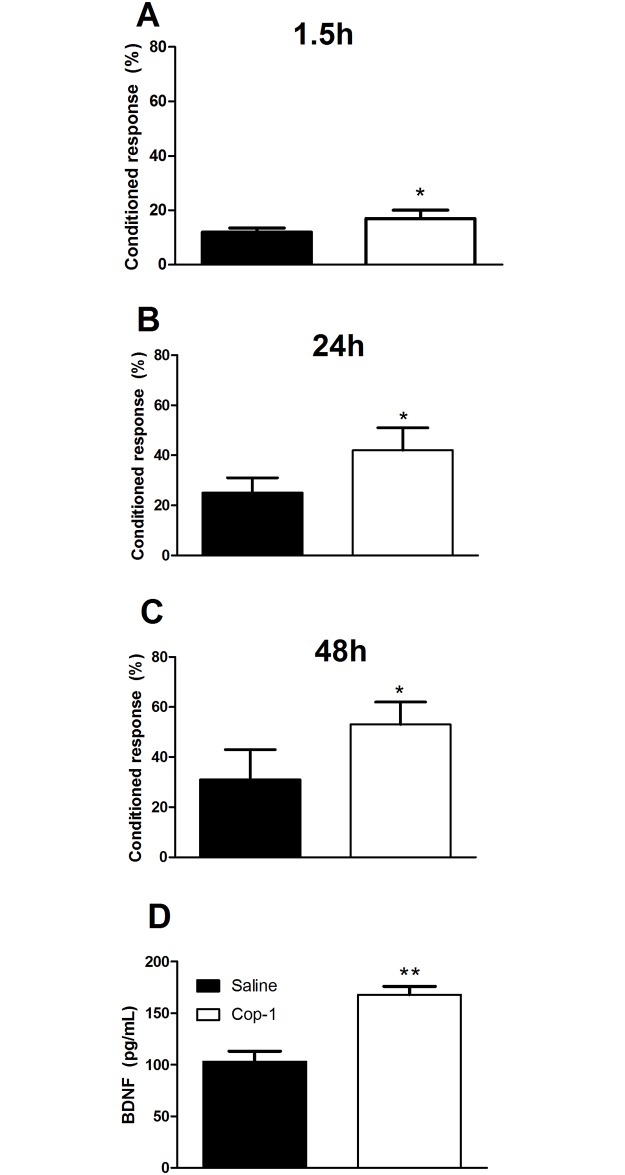
Cop-1 immunization improved associative memory and increased BDNF levels in adult rats, when administered from the early stages of life.Young animals (3 months old) were immunized and evaluated at 6 months of age using the autoshaping test. Cop-1 immunization was capable of improving associative memory at 1.5 (A), 24 (B), and 48 (C) hours after training. BDNF levels were also significantly increased (D). Each bar represents mean ± SD of 8 (Figures A, B and C) or 4 (Figure D) rats. *p = 0.05, ** p< 0.01 Student’s T test. This experiment is one of two in which the same effect was observed.